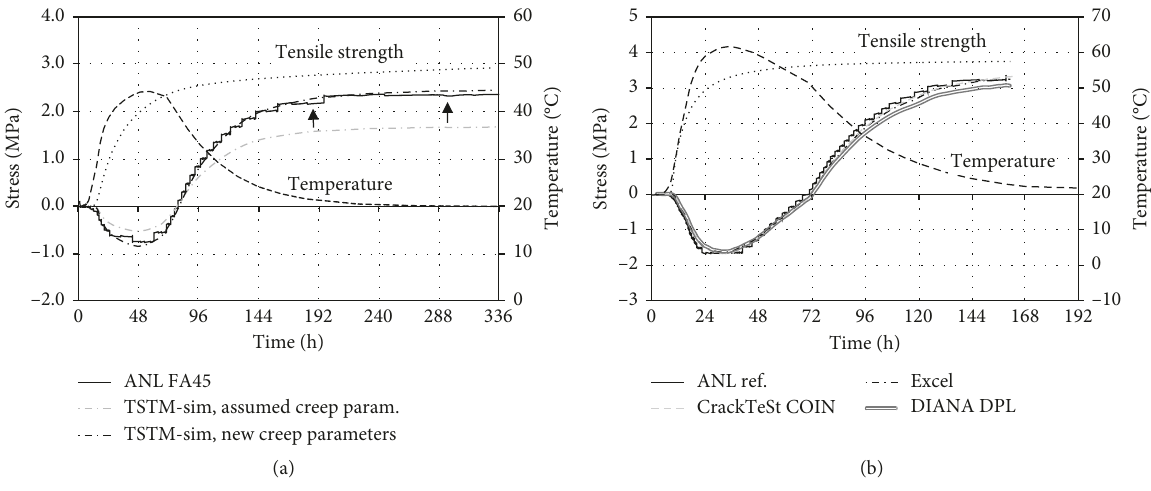
Figure 5: Measured and calculated stress development in the TSTM: ANL FA45 (a) and ANL ref. (b).